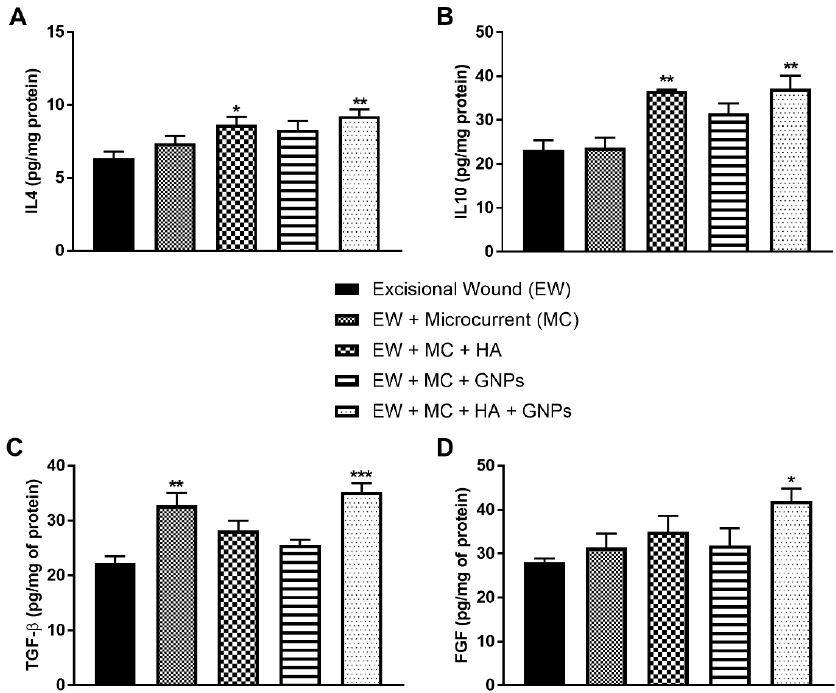
Figure 6. Effects of treatment with MC, GNPs, and hyaluronic acid on the protein levels of anti- inflammatory cytokines: ( A ) IL4; ( B ) IL10; ( C ) TGF- β; ( D ) FGF. The data are presented in mean ± EPM, in which * p < 0.05 vs. excisional wound group (EW); ** p < 0.01 vs. excisional wound group (EW); *** p < 0.001 vs. excisional wound group (EW) (one- way ANOVA followed by Tukey’s post hoc test).